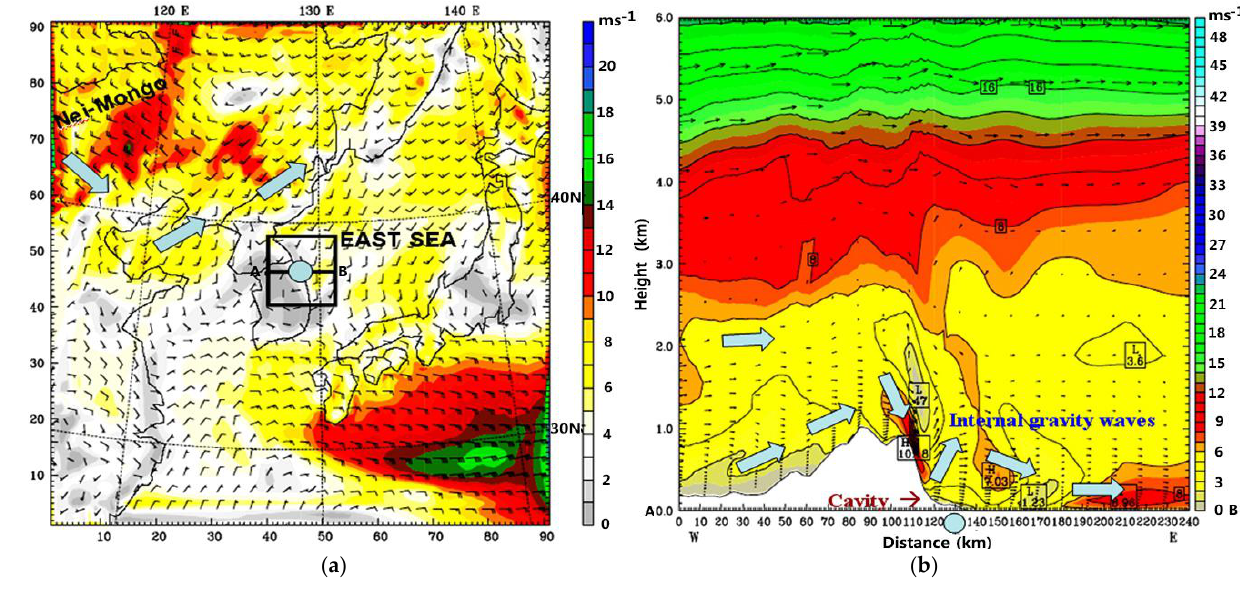
Figure 6 . ( a ) Surface wind (m/s) in north-eastern Asia (the first domain of a horizontal grid interval of 27 km) including the vicinity of Gangneung city on the Korean east coast (a small square; the third domain of 3 km grid interval in the WRF model simulation) at 09:00 LST, 29 March 2004, and ( b ) vertical profile of horizontal wind (m/s) on a straight cutting line in A-B ( a ). A small circle denotes Gangneung city. Southwesterly strong downslope wind could generate an IGW bounding up and down in the vicinity of the city in ( b ). The dusts emitted from the city merged below the IGW, causing a high PM 10 concentration in Figure 2.